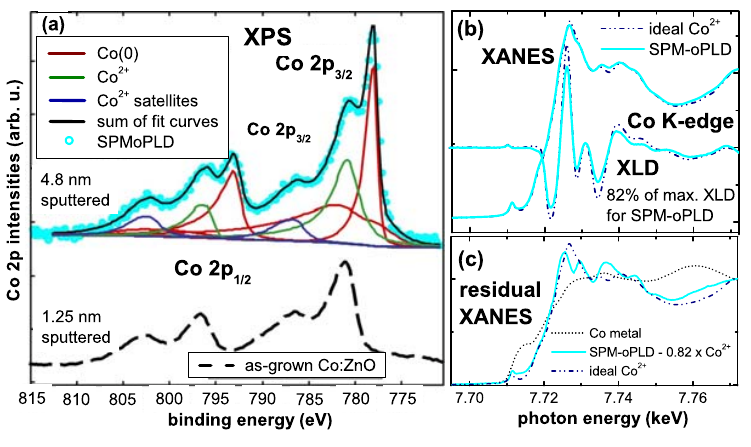
Figure 14. (a) Fit of an XPS spectrum of SPM-oPLD after sputter-removal of the topmost 4.5 nm of the film to a superposition of Co 2+ and Co (0) revealing a fraction of metallic Co. For comparison an XPS spectrum for the as-grown sample after removal of the topmost 1.25 nm is shown. (b) XANES and XLD at the Co K -edge of the SPM-oPLD sample compared to the PM-oPLD sample. The residual XANES in (c) amplifies the spectroscopic signatures of the phase separated